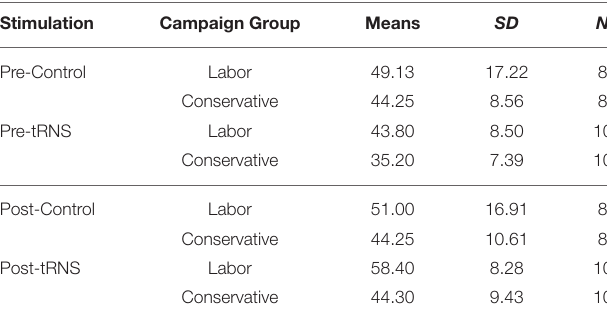
TABLE 2 | Means and SD for political attitude: pre–post stimulation.